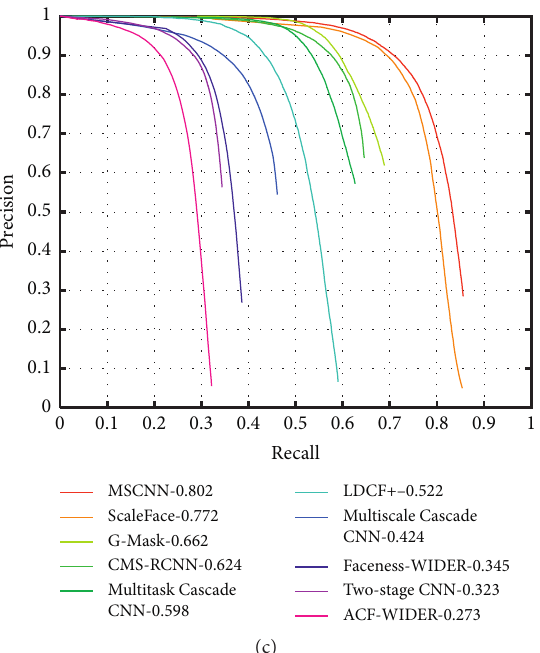
Figure 8: The precision-recall curve on the WIDER FACE benchmark: (a) on the easy subset, (b) on the medium subset, and (c) on the hard subset.